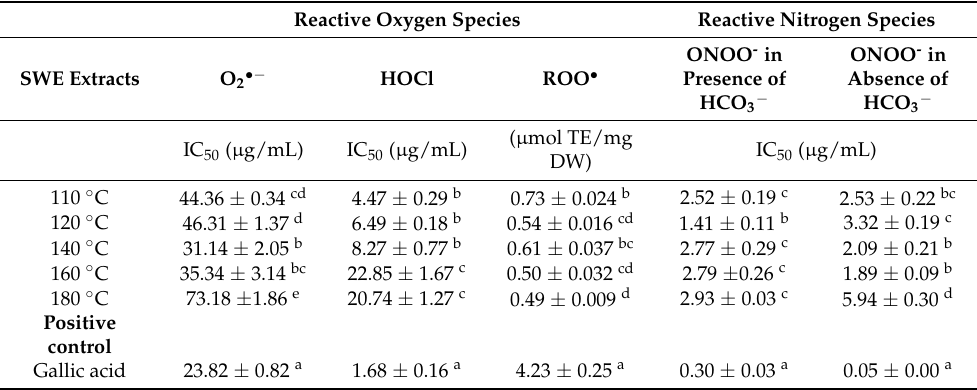
Table 3. Superoxide anion radical (O 2 • − ), hypochlorous acid (HOCl), peroxyl radical (ROO • ) and peroxynitrite (ONOO - ) scavenging capacities of C. sativa shells SWE extracts. Values are expressed as mean ± standard deviations ( n = 3). Different letters (a, b, c, d) in the same column indicate significant differences between extracts ( p <